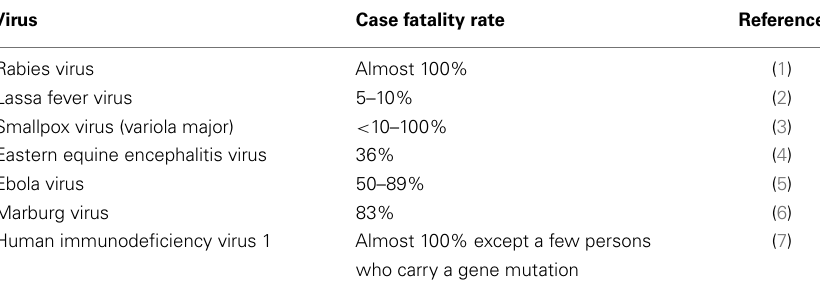
Table 1 | Case fatality rate of some highly pathogenic viruses